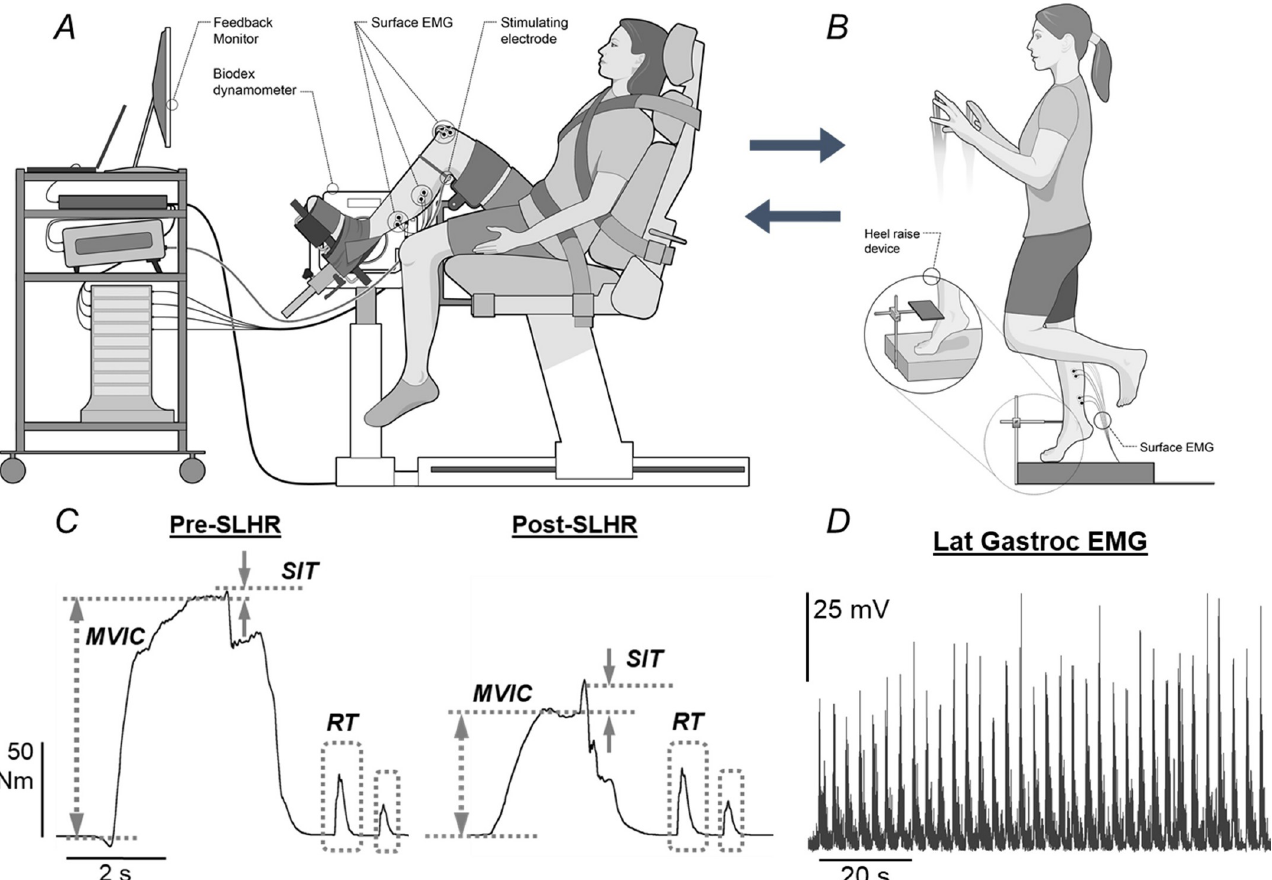
Fig 1. Experimental setup, study protocol, and raw data. A : Experimental setup of a participant in the Biodex System3 Pro dynamometer used for baseline and post-SLHR task measurements. Participants were given visual feedback on a monitor. Surface electromyography (EMG) was recorded for the medial and lateral gastrocnemius, soleus, and anterior tibialis muscles. Electrical stimulation was positioned over the tibial nerve. B : Experimental setup for the SLHR task. Participants stood on a custom-made heel raise device (see inset). Surface EMG was similarly recorded for the duration of the SLHR task. C : Representative torque data from a female participant, before and after the SLHR task. Measurements included: Maximal voluntary isometric contraction (MVIC), superimposed twitch (SIT), and resting twitch (RT). The MVIC decreased and SIT increased following the SLHR task, leading to reduced voluntary activation. D : Root-mean- squared (RMS) EMG data recorded during the SLHR task. The representative data is from the lateral gastrocnemius of the female participant from C and shows an increase in EMG amplitude.